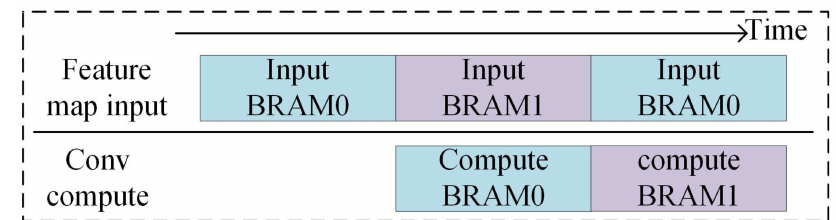
Figure 7. Workflow of ping-pong